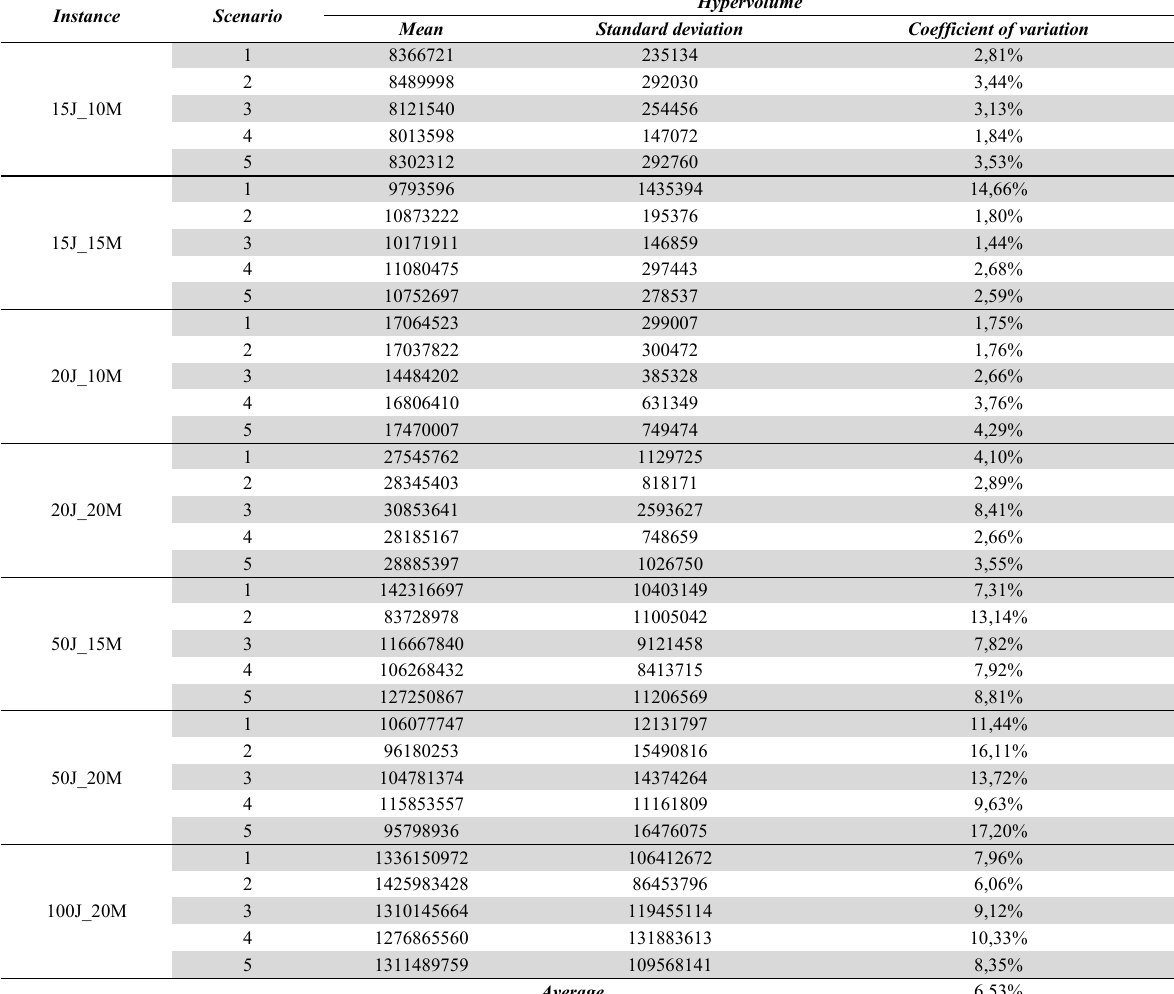
Hypervolume analysis for the larger